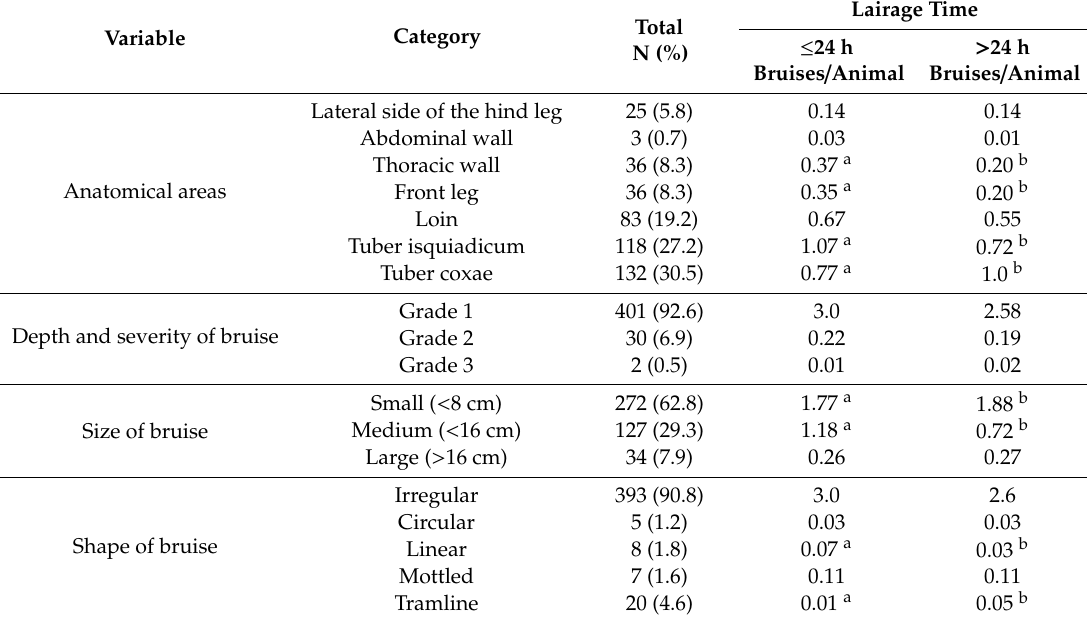
Table 7. Bruising characteristics according to the lairage time type ( ≤ 24 h vs. > 24 h) of cull cows at abattoir ( n = 433 bruises; n = 195 vs. n = 237).